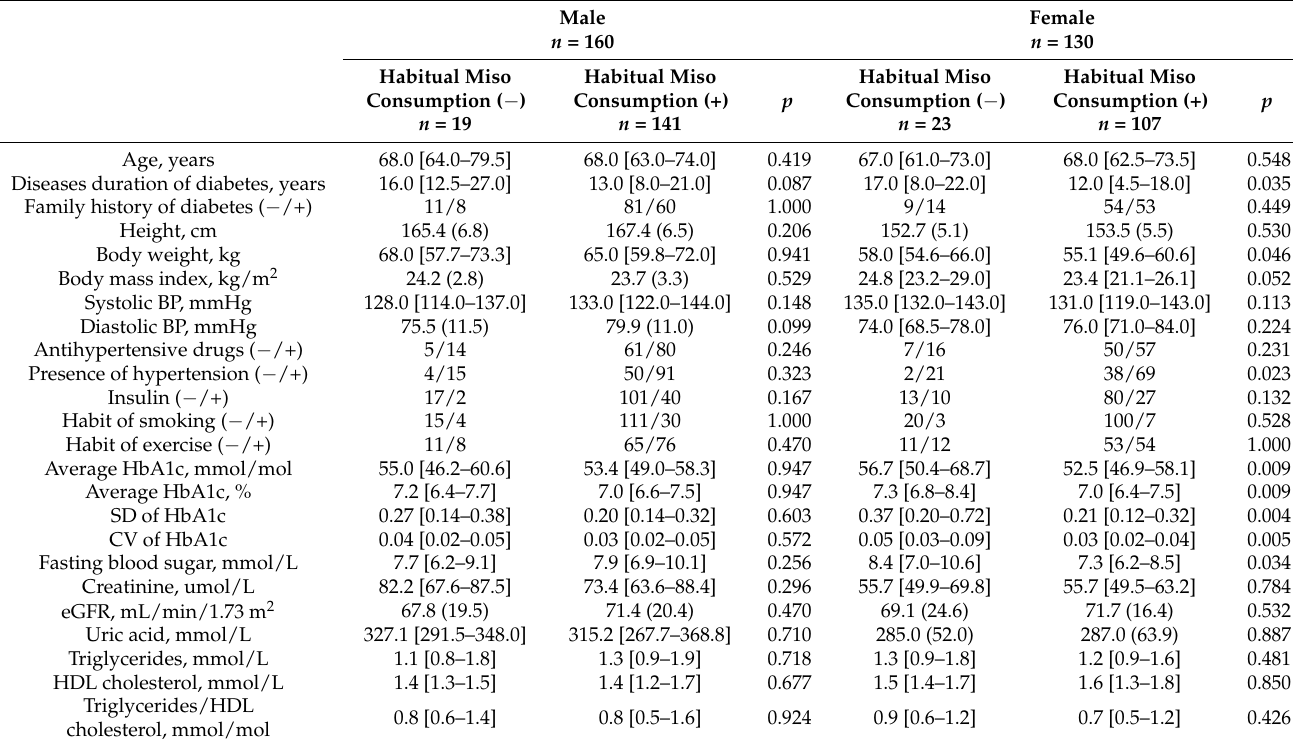
Table 3. Clinical characteristics according to habitual miso